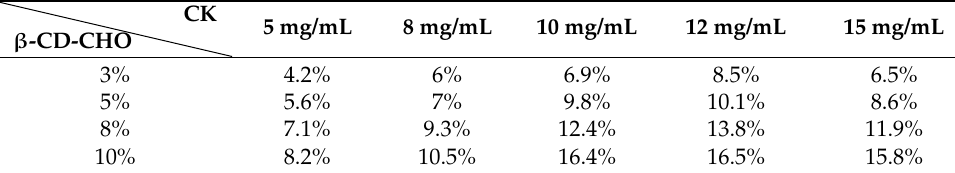
Table 1. Different concentrations of DA- β -CD and CK drug loading. β